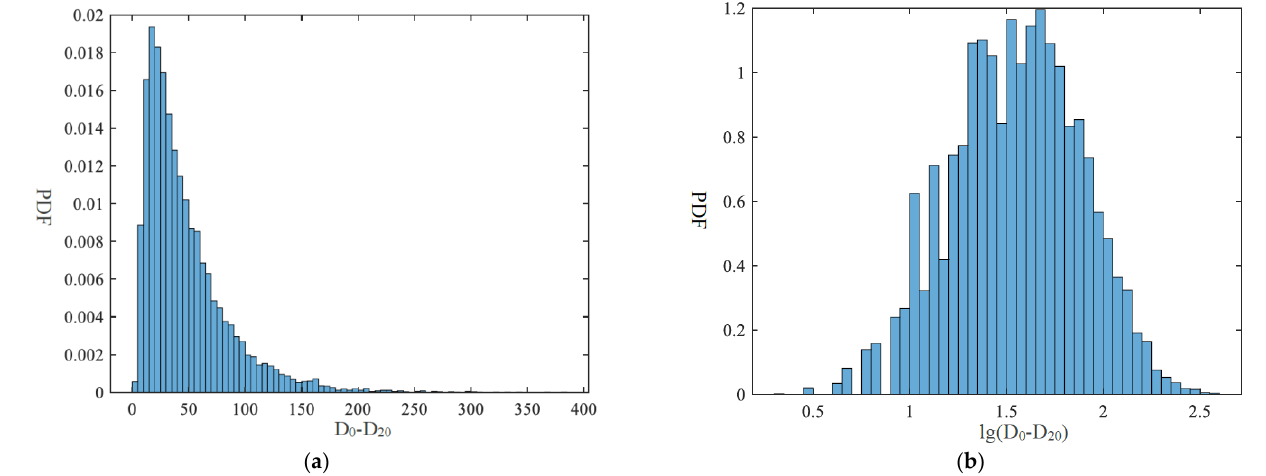
Figure 4. Histogram of deflection parameters: ( a ) D 0 – D 20 ; ( b ) lg(D 0 – D 20 ).